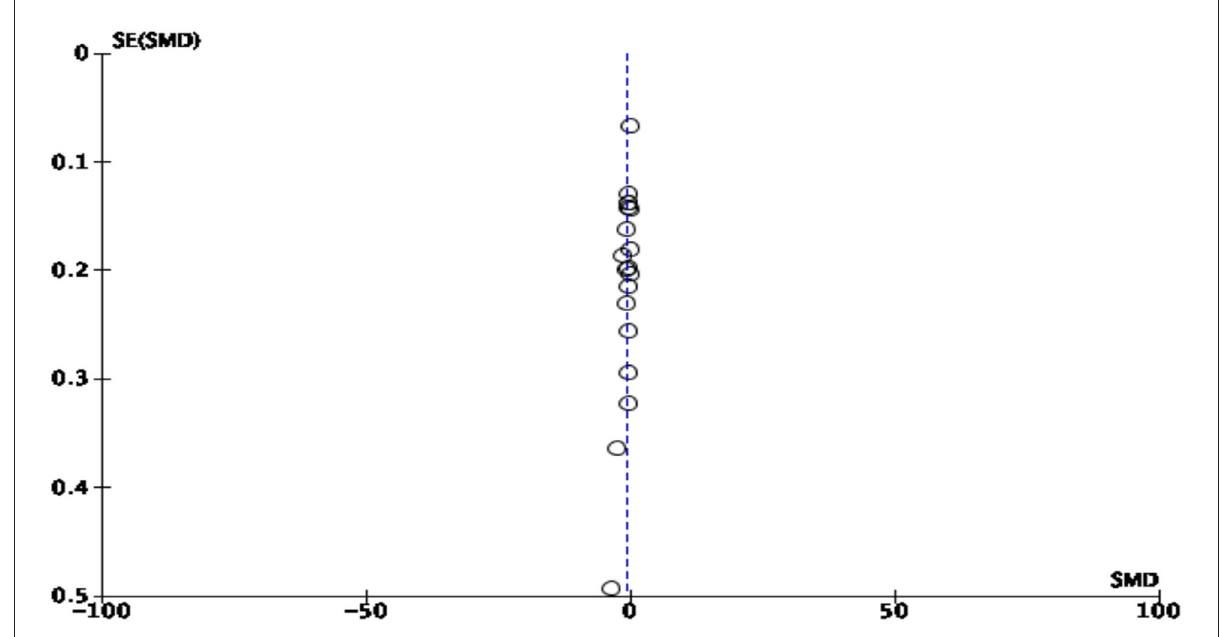
FIGURE5 Funnel plot for publication bias in HbA1c